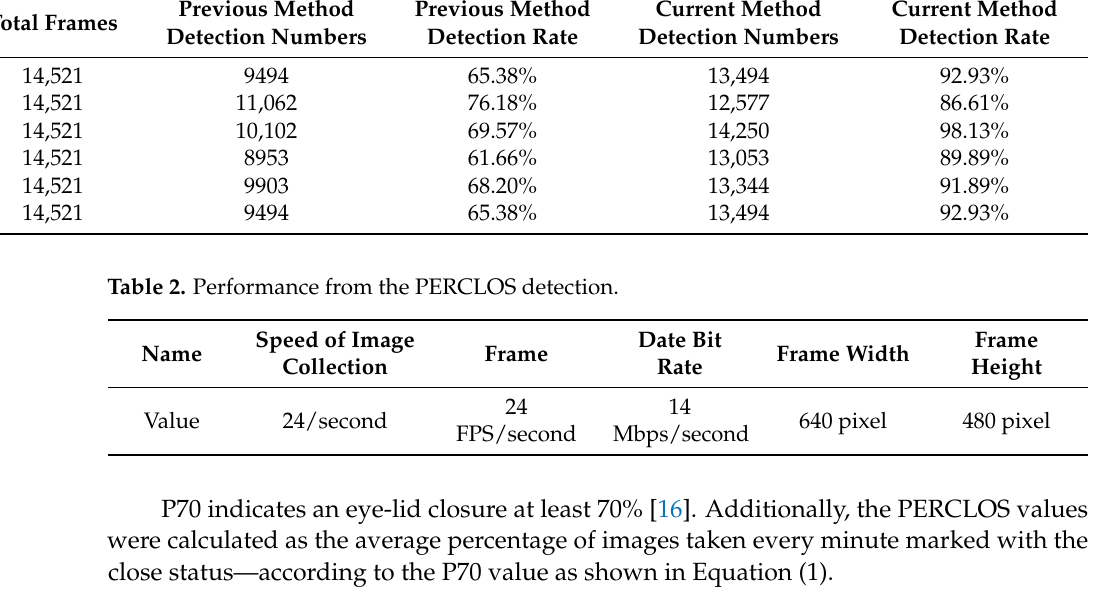
Table 1. Comparison of the effectiveness for the face detection between previous and current method. Sample No.